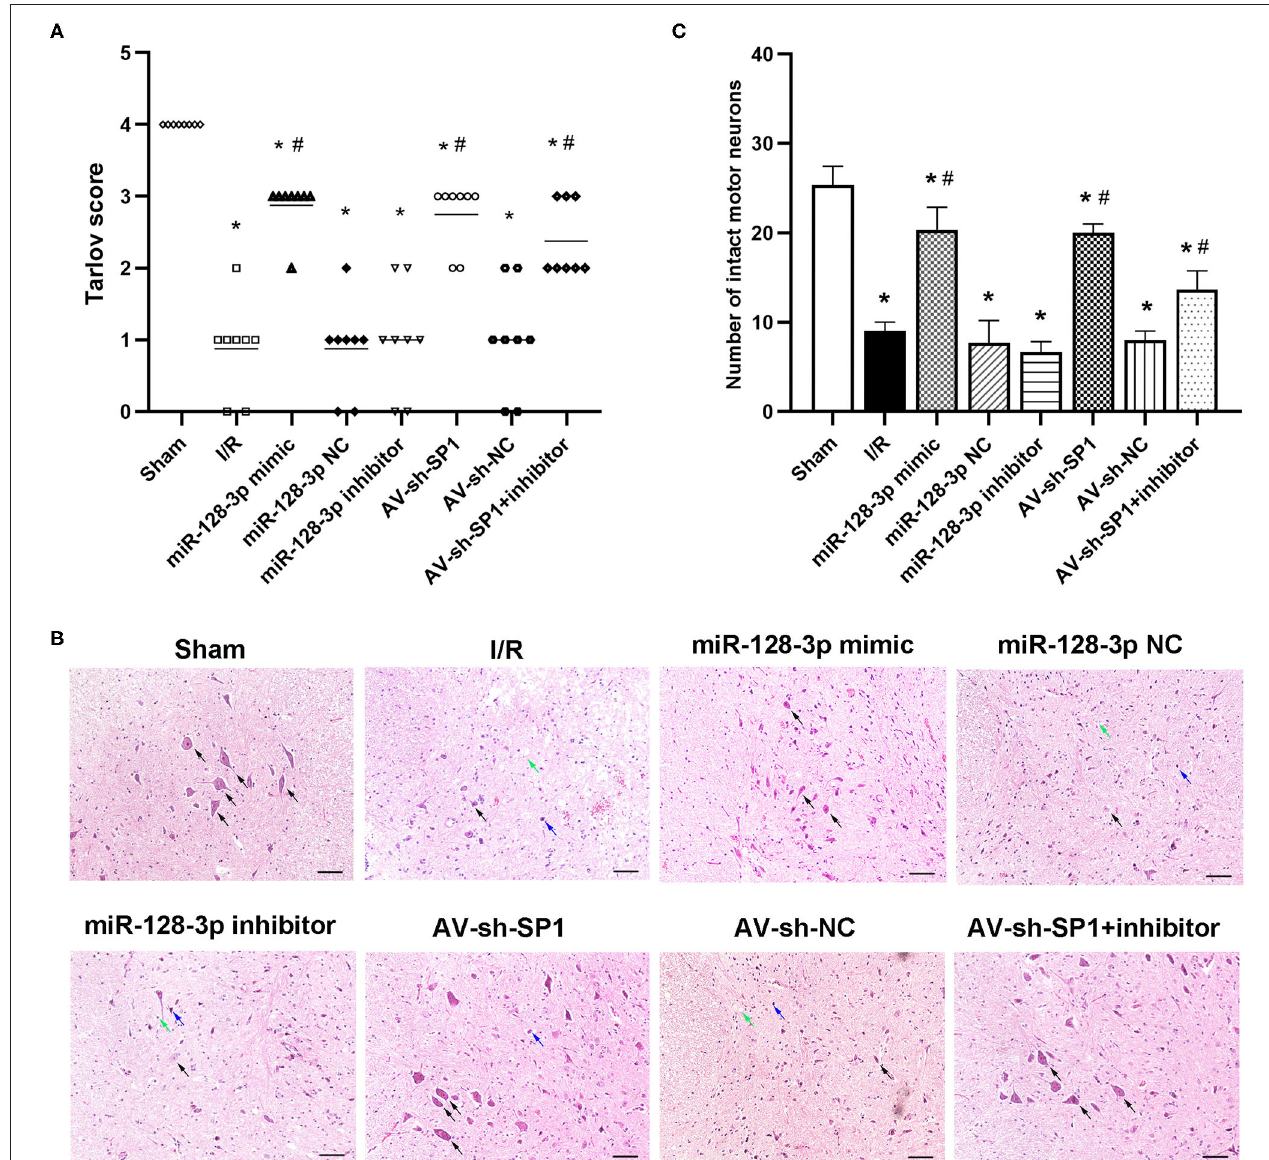
FIGURE 5 | Effects of miR-128-3p mimic and AV-sh-SP1 on neurological function and histologic evaluation after I/R. (A) Neurological function scores at 12h after I/R in eight groups. Tarlov scores ranged from 0 (paraplegia) to 4 (normal). Each symbol represents one rat ( n = 8). (B) Representative sections of L4–L6 spinal cord segments in the central horn of gray matter stained with hematoxylin and eosin 12h after I/R in eight groups. Scale bar = 100 µ m. (C) Numbers of intact motor neurons of ventral gray matter in the eight groups. The black arrows indicate normal neurons. The blue arrows indicate dead neurons with a diffuse cytoplasm without cellar structure. The green arrows indicate loosened tissue organization. * P < 0.05 vs. sham group. # P < 0.05 vs. IR or NC